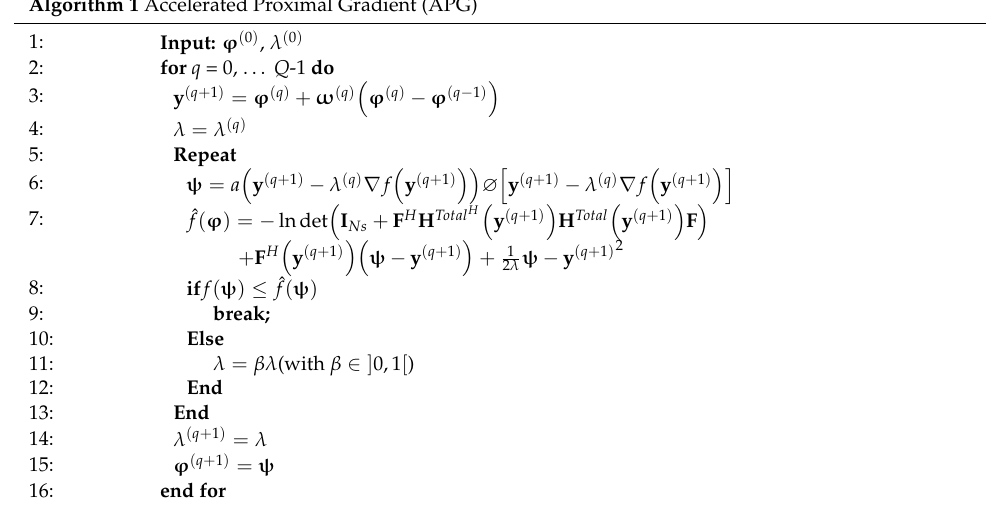
Algorithm 1 Accelerated Proximal Gradient